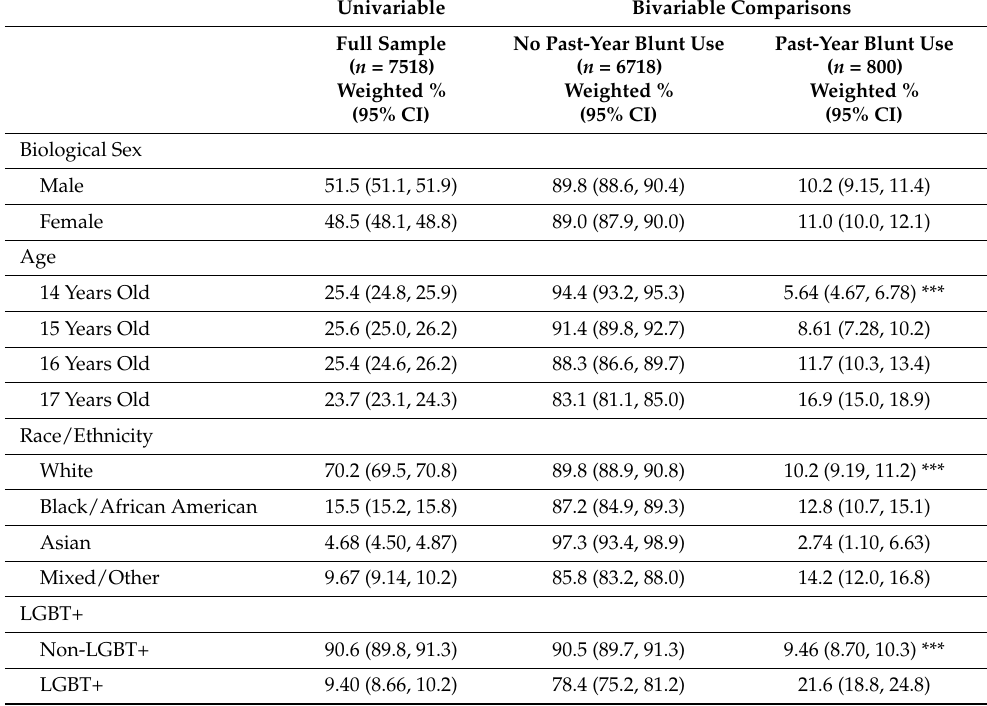
Table 1. Demographics and Bivariate Comparisons.